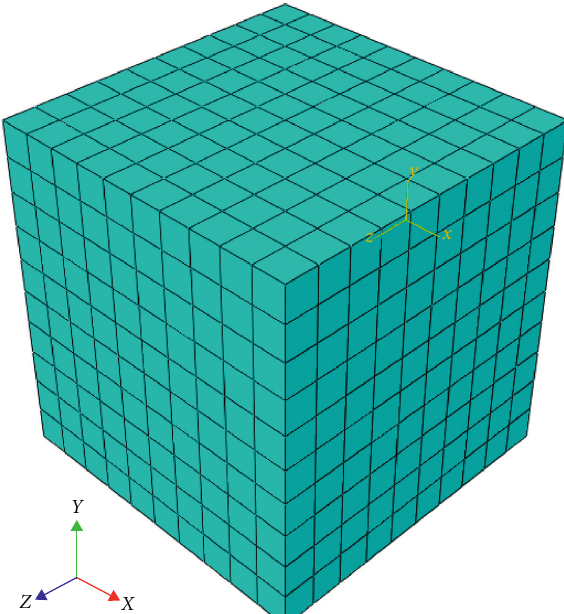
Figure 2: The cube test block of rock.